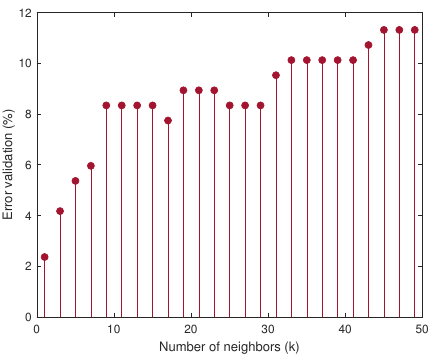
Figure 10. Results of the leave-one-out cross-validation for the k-Nearest Neighbor